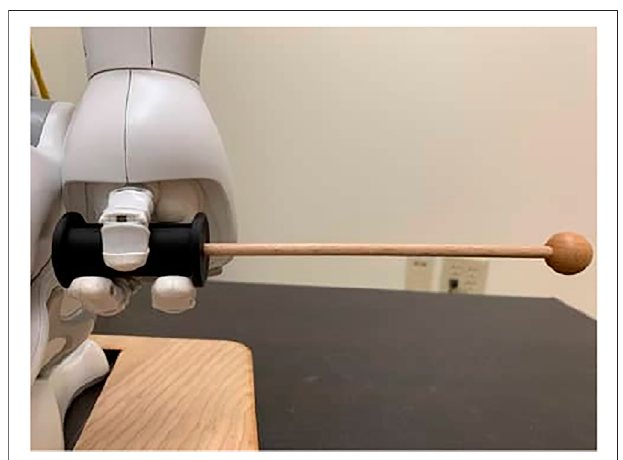
FIGURE 1 | Mallet